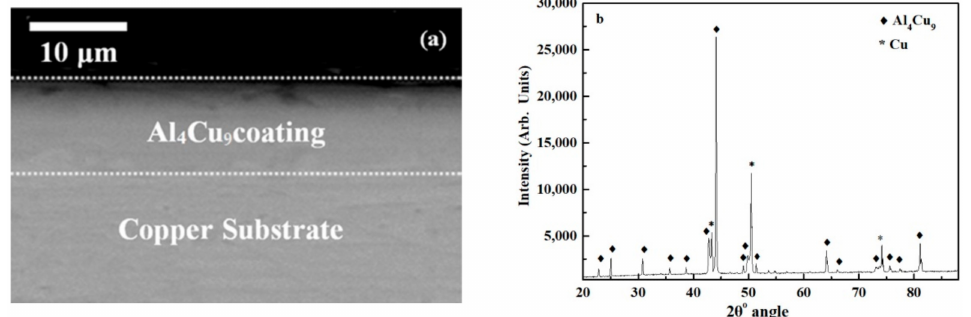
Figure 2. SEM micrograph of the Al coatings deposited at 550 ◦ C for 2 h ( a ), and corresponding XRD pattern ( b ) (The identification was accomplished by using the following JCPDS Cards: #02-1254, # 65-3347 for Al 4 Cu 9 and #04-0836 for